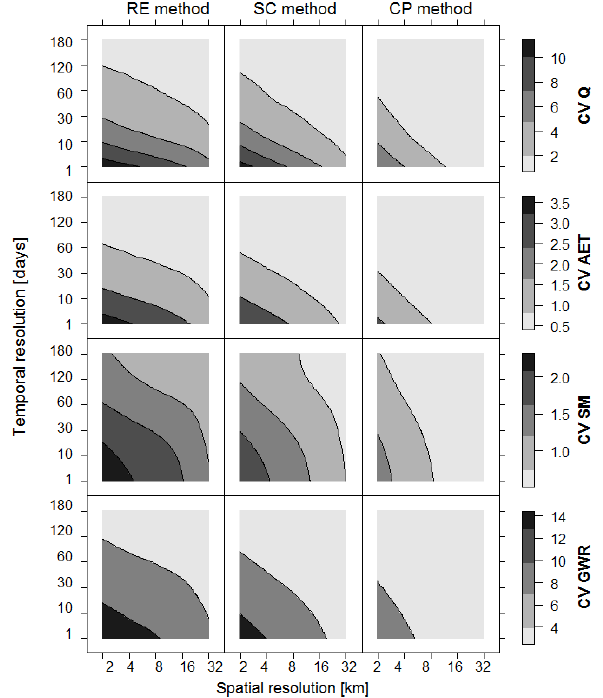
Figure 10. Spatio-temporal uncertainty analysis by aggregating the model results at different spatial and temporal resolutions. The three columns refer to the results obtained by (left) random error method - RE, (middle) spatially correlated method – SC and (right) condi- tional points method – CP. The rows refers to the different model outputs (i.e. Q is runoff, AET is actual evapotranspiration, SM is soil moisture; GWR is groundwater recharge). Note that a smooth approximation is depicted to facilitate the visualization of the actual CVs